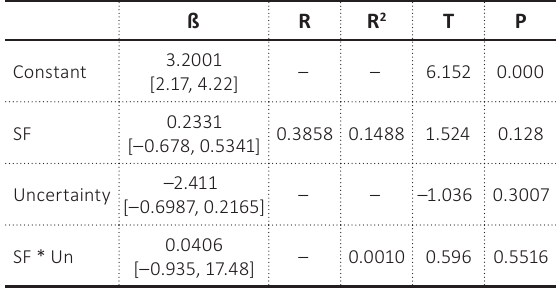
Table 6. Moderated regression analysis (uncertainty as a